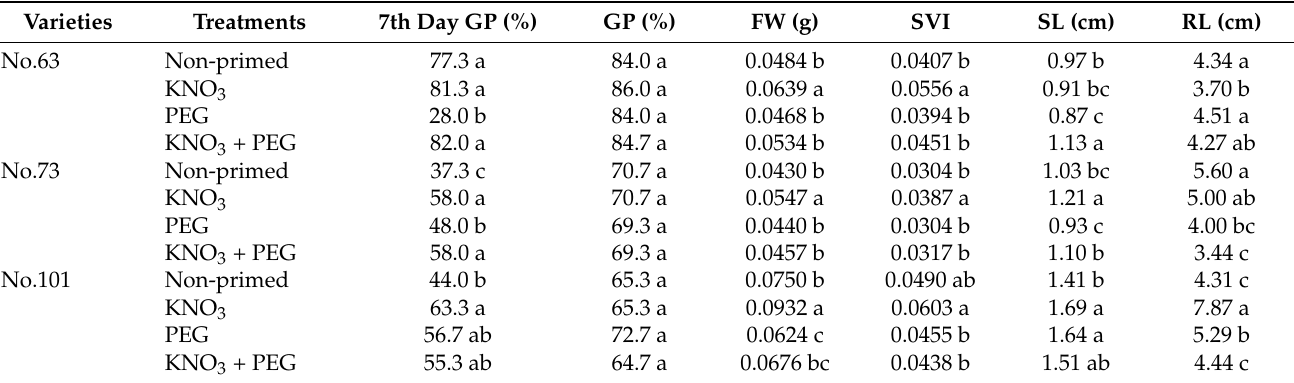
Table 3. Effects of priming with KNO 3 , PEG, and KNO3 + PEG on germination of three varieties of pepper seeds.